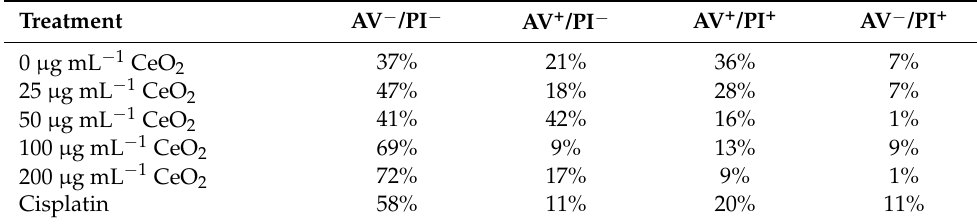
Table 1. Flow cytometry gated profiles of viable (AV − /PI − ), early apoptotic (AV + /PI − ), apoptotic and necrotic (AV + /PI + ), and already dead (AV − /PI + ) cells treated with varying concentrations of CeO 2 NP, or Cisplatin.